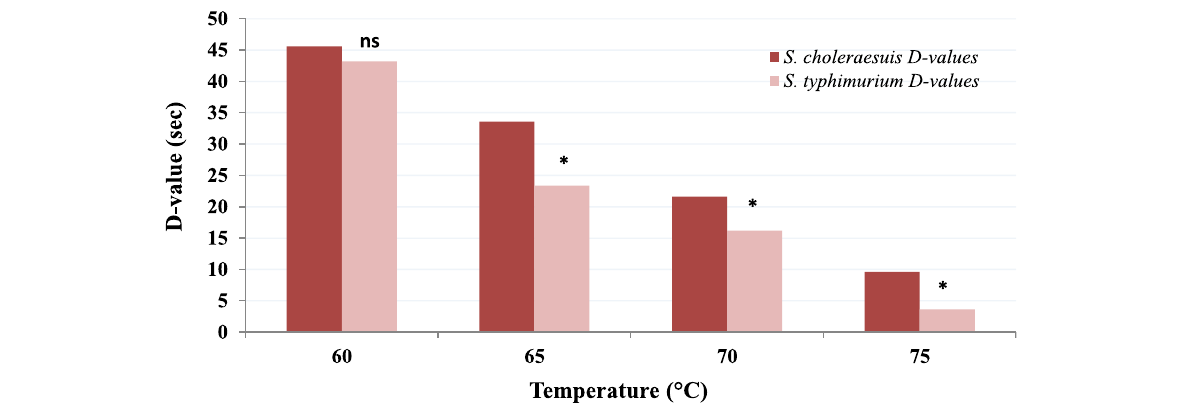
Fig. 1 Histogram comparing the D values of S. typhimurium and S. choleraesuis grown under different temperatures. *Significant difference between both bacteria at temperature. ns, no significant difference